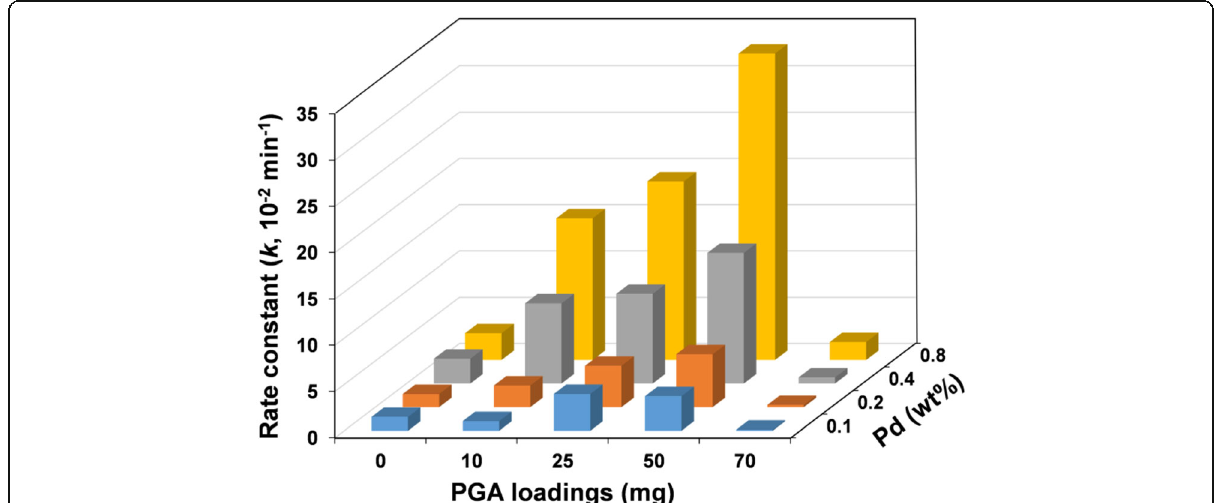
Fig. 4 The rate constant of dechlorination of p -CP with different PGA and Pd